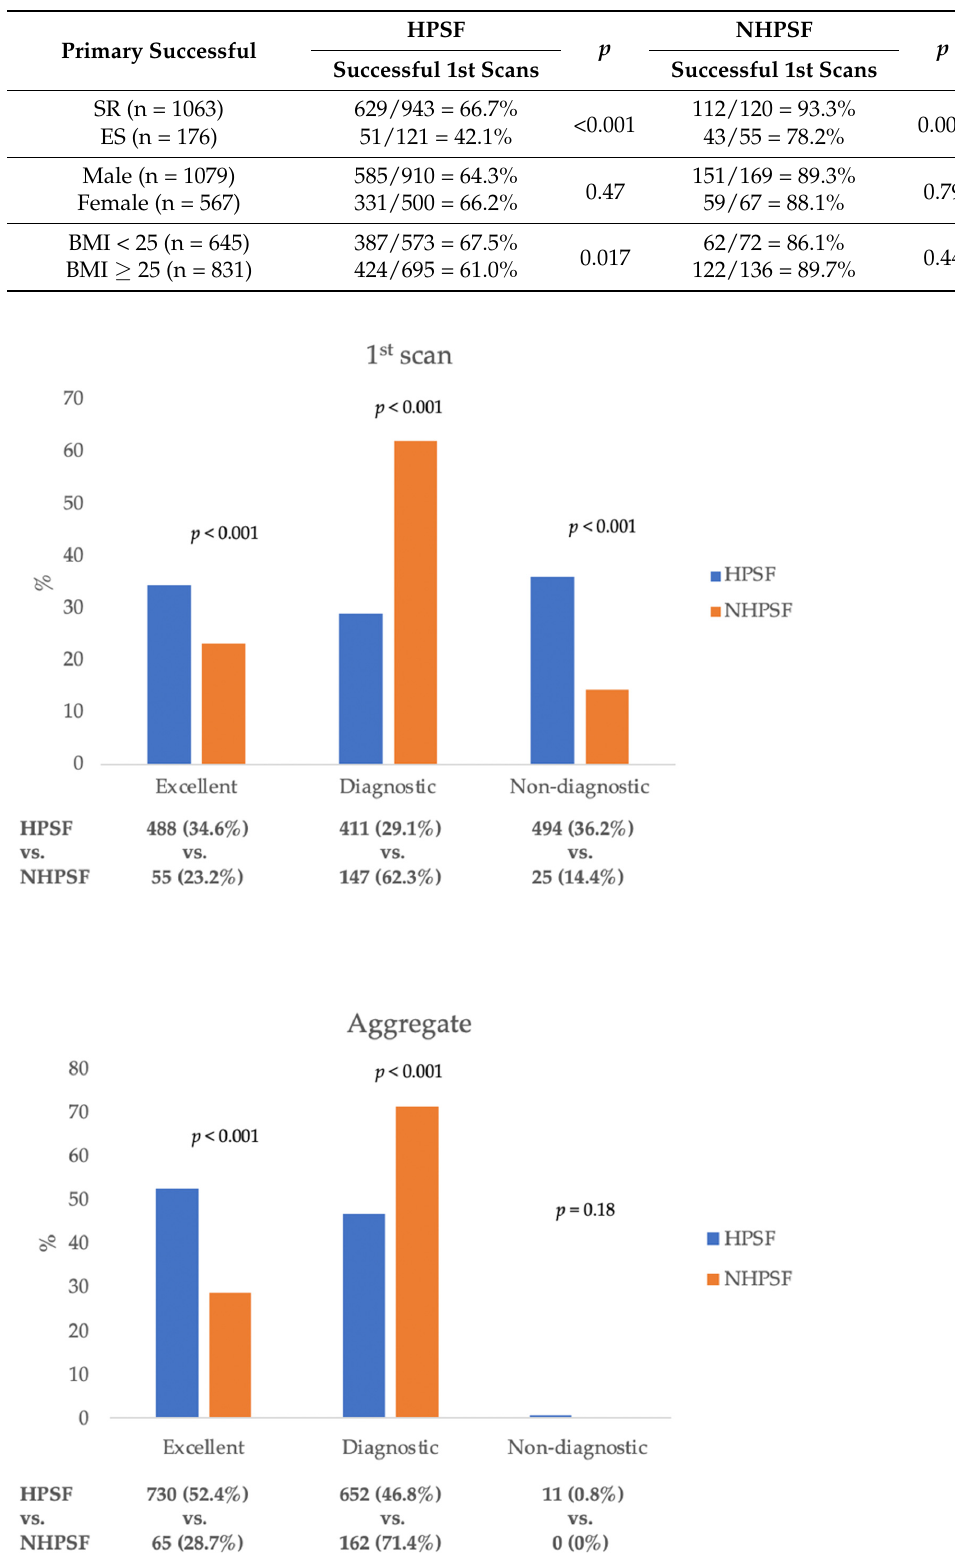
Figure 3. The image quality of the first scan as well as the aggregate of the first and potential second CCTA for patients with the HPSF and NHPSF protocol. HPSF: high-pitch spiral first; NHPSF: non-high-pitch spiral first.